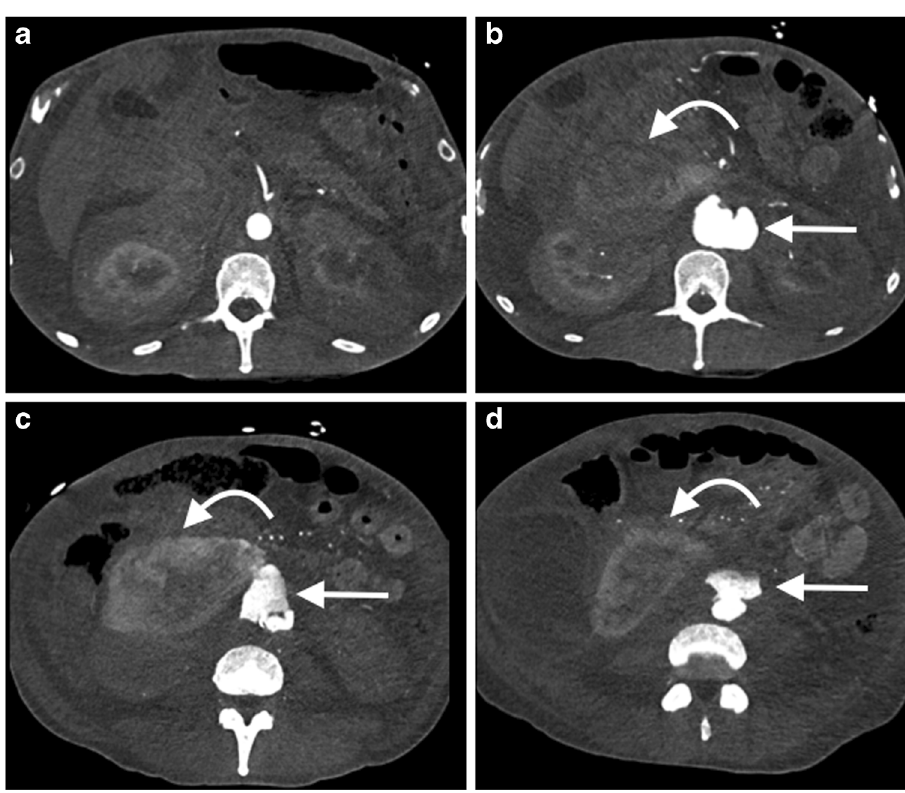
Fig. 9 Selected axial images ( a- d ) from an arterial phase CT angiogram of the abdominal aorta in a 55-year-old man with hypo- tension and abdominal pain dem- onstrates a large retroperitoneal haematoma ( curved arrow ) and active extravasation from the infrarenal abdominal aorta ( arrow ) consistent with aortic rupture. A ruptured mycotic an- eurysm was found in the operat- ing